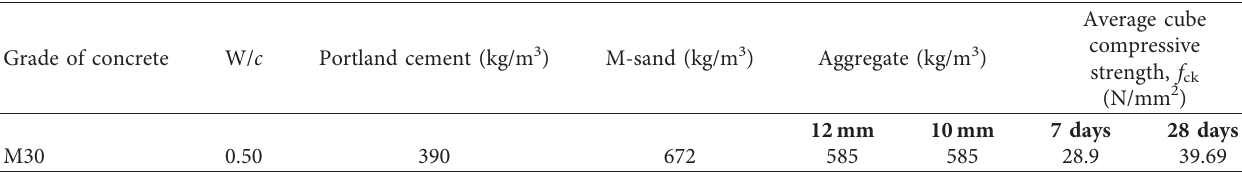
Table 2: Mix proportion details.